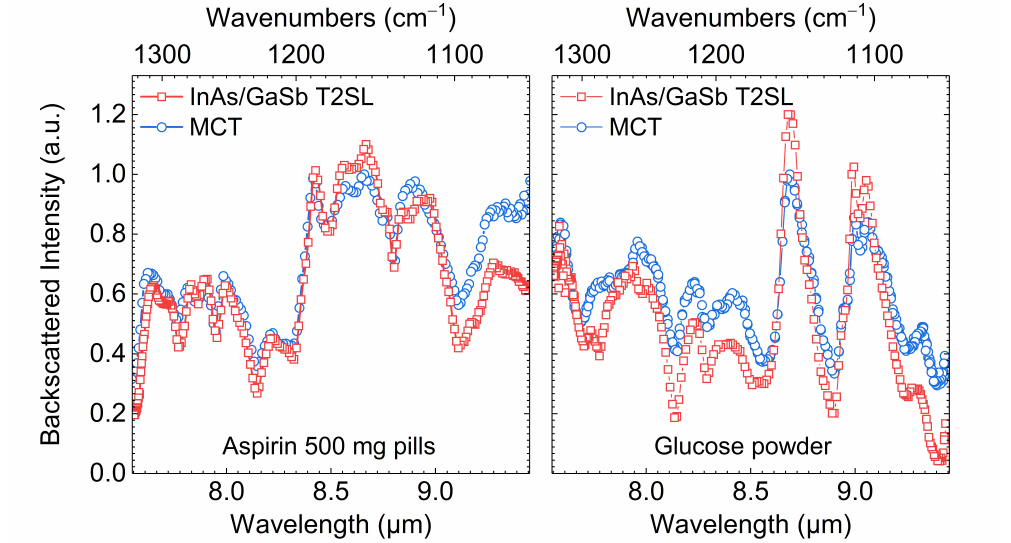
Figure 6. Di ff use IR reflectance spectra obtained from aspirin 500 mg pills and glucose powder with the two IR detector modules featuring a HOT InAs / GaSb T2SL IR detector and a HOT MCT IR detector during operation of the demonstrator